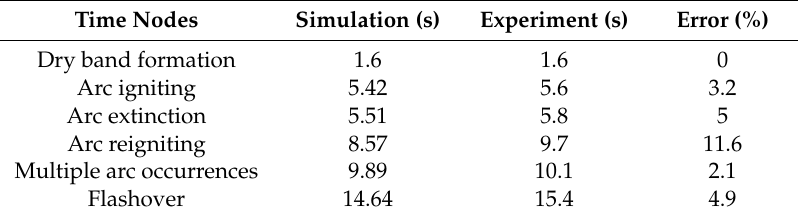
Table 1. Comparison of time nodes between experimental and simulation results.